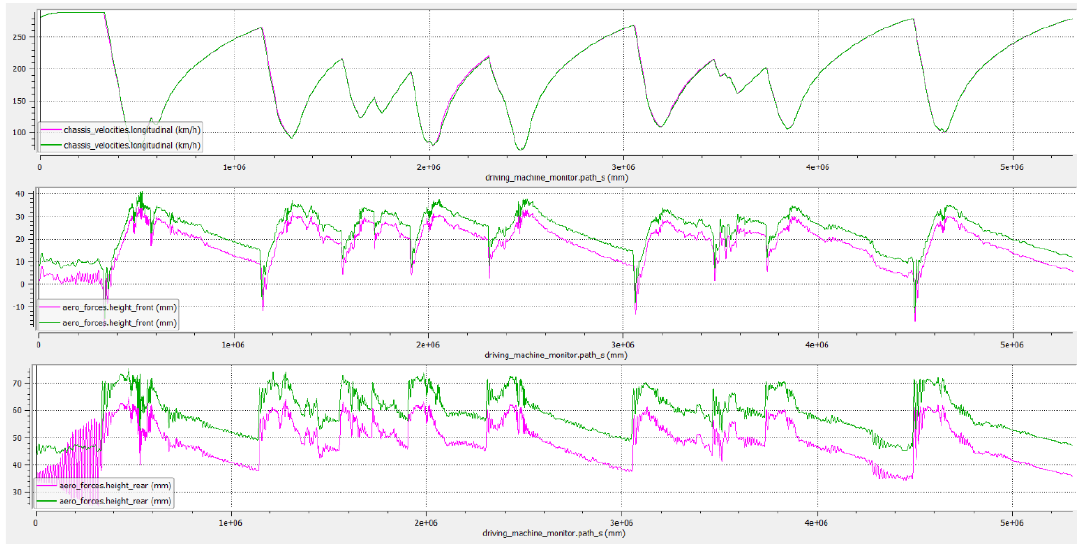
Figure 34. Setup #3 (purple) vs. #4 (green). Setup #3 is a reasonable tradeoff between the reduction of porpoising (and of driver discomfort as well) and performance in terms of average downforce. Top plot is the speed profile vs. lap distance, mid and bottom plots are the front and rear ride